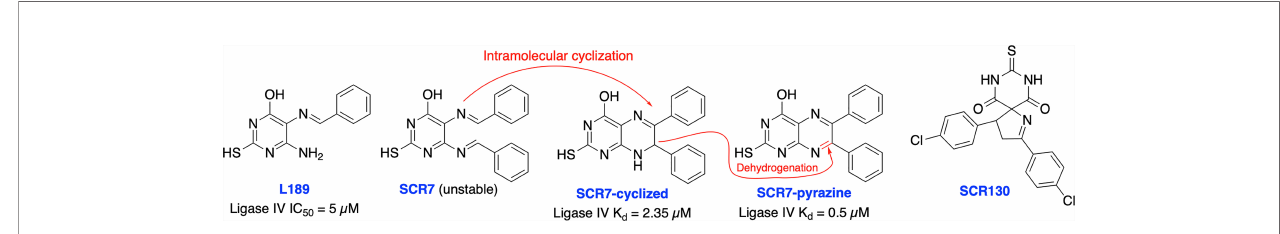
FIGURE 6 | Small molecule inhibitors targeting DNA Ligase IV and their IC50 values for either inhibition of Ligase IV adenylation or Ligase